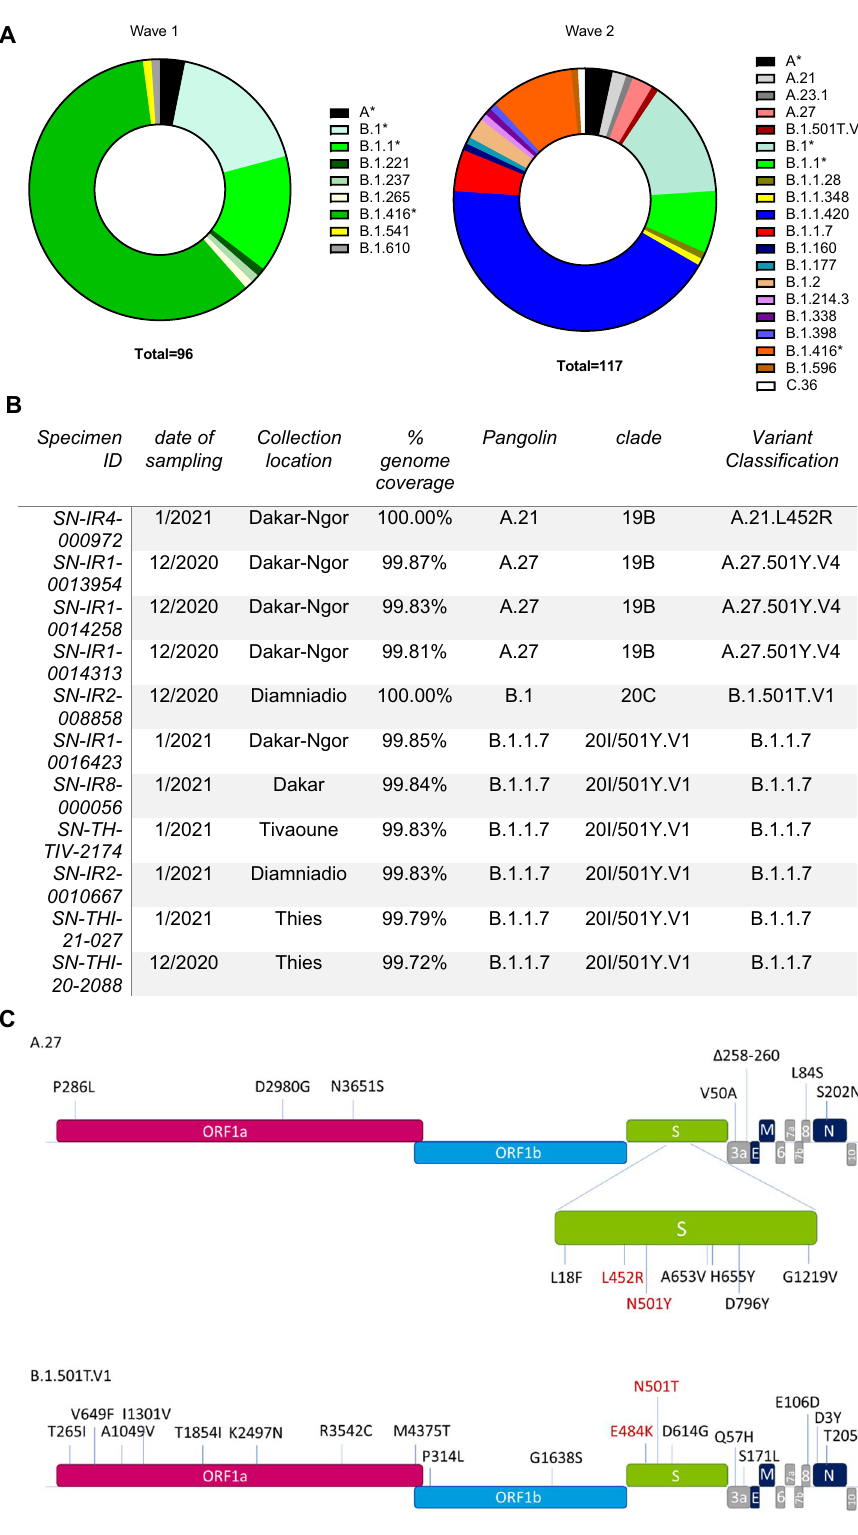
Figure 1. Molecular surveillance of SARS-CoV-2 in Senegal. In panel ( A ), the number of sequences classified in the indicated lineages present in waves one and two are shown proportionally to the total number of sequences generated with > 60% genome coverage from each wave as designated in the total numbers below each plot. An * indicates lineages that were present in both waves. In panel ( B ), the sequence and specimen metadata are listed for each strain carrying spike mutation of concern at position 501, 484, or 452. All sequences in this panel are from wave two. In panel ( C ), the lineage defining amino acid mutations (in comparison to the reference genome NC_045512) for the new strains identified in this study are shown. ( A ) Lineages identified, ( B ) Variant specimen summary, ( C ) Escape variant